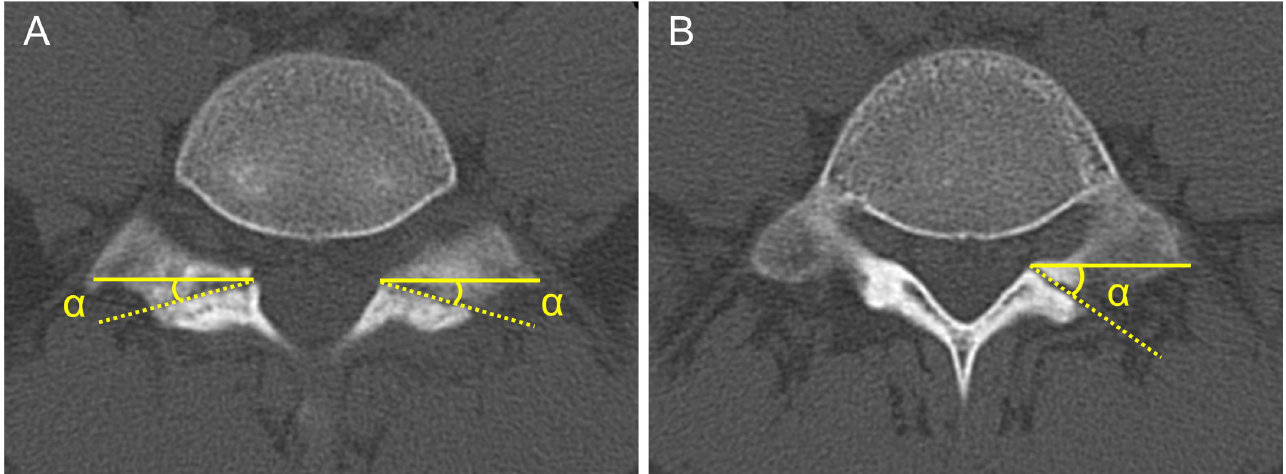
Fig 2. Measurement of spondylolysis fracture angle (SFA). The SFA ( α ) was defined as the angle between the line parallel to the posterior cortex of the vertebral body (solid line) and fracture line (dotted line), with the direction of the spinous process being positive. (A) Bilateral spondylolysis. (B) Unilateral spondylolysis.